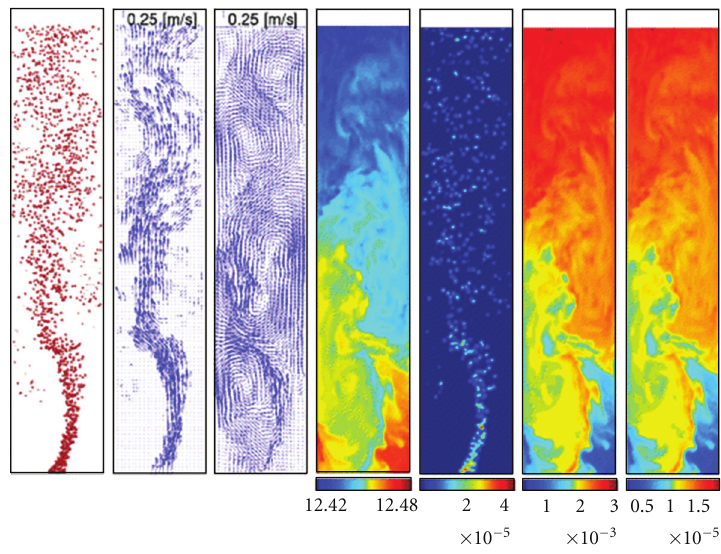
Figure 14: Instantaneous solution 10s after the CO 2 gas is introduced. From left to right: bubble positions, gas velocity, liquid velocity, pH, respectively, and concentration of dissolved CO 2 , HCO − , and CO 2− (kmol m −3 ) (from Darmana et al. [77]).